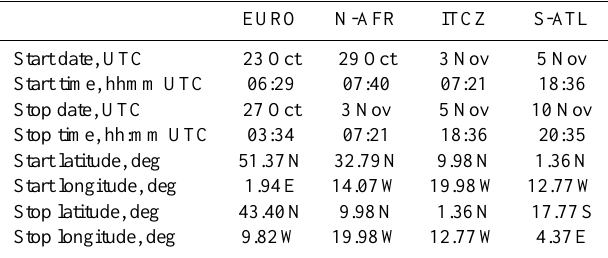
Table 1. Start and stop dates, times, and positions for the four trans- port